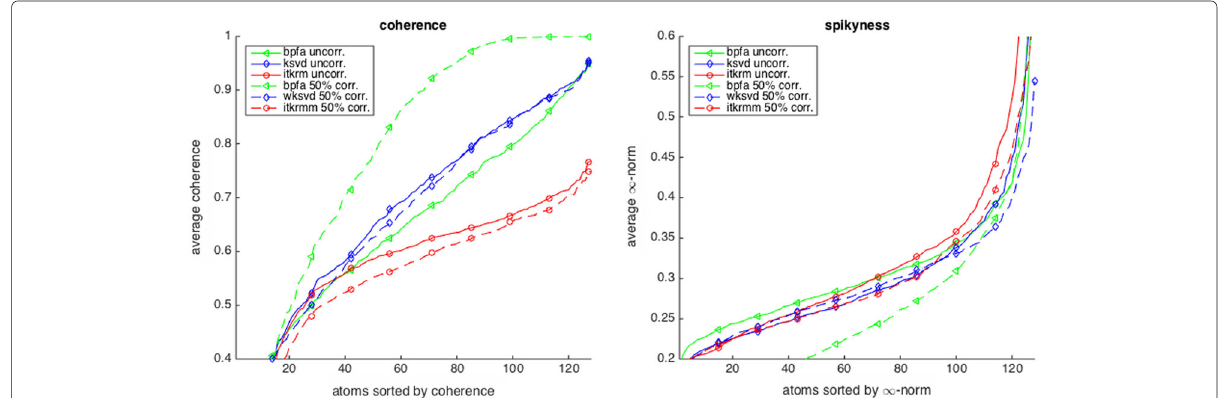
Fig. 7 Average coherence (left) and spikiness (right) of the dictionary atoms learned on Barbara by BPFA, (w)KSVD and ITKrM(M) on uncorrupted data and 50% corrupted